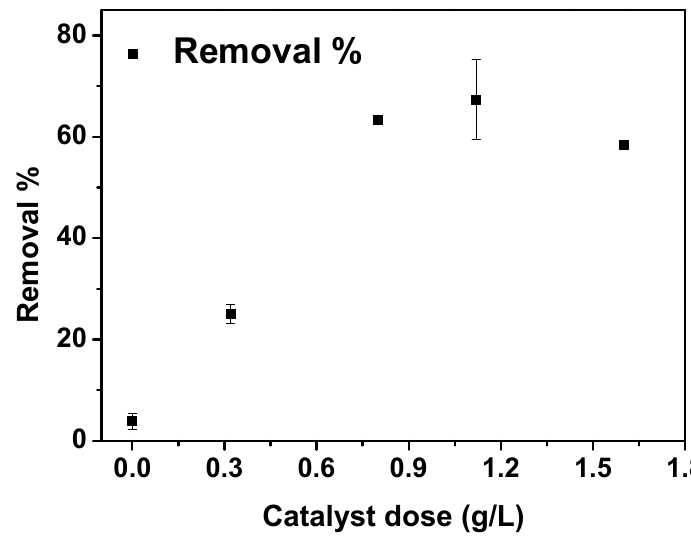
Figure 7. Removal ratios of MB by 4% PANI/TiO 2 with different catalyst doses under visible-light irradiation (MB = 5 µ M).